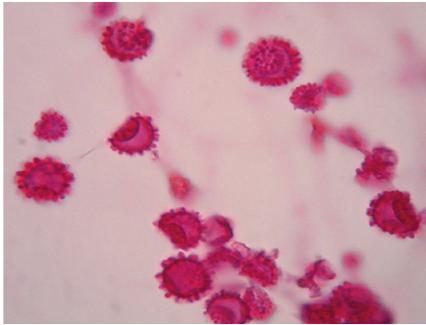
Figure 18: Microscopic view of microculture of Histoplasma capsulatum PAS stained. From scleritis case sample, described in Figure 16 × 400 magnification.